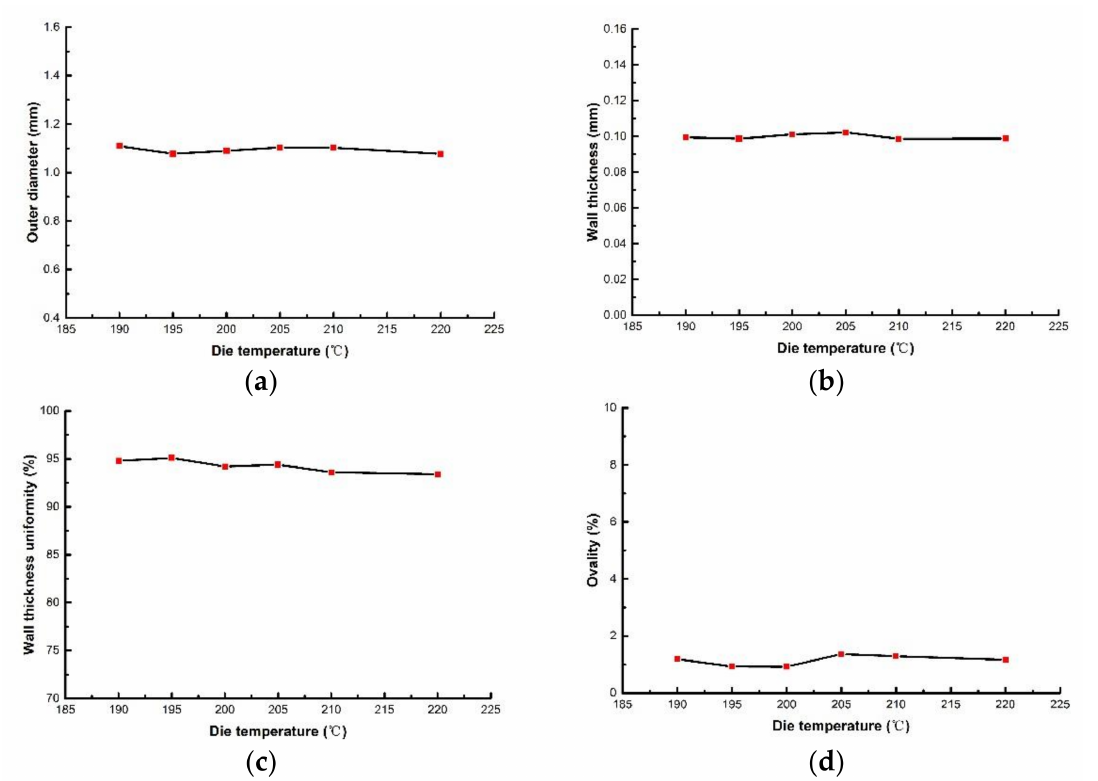
Figure 11. The relationships between evaluation index with die temperature: ( a ) The relationship between outer diameter with die temperature; ( b ) The relationship between wall thickness with die temperature; ( c ) The relationship wall thickness uniformity with die temperature: ( d ) The relationship between ovality with die